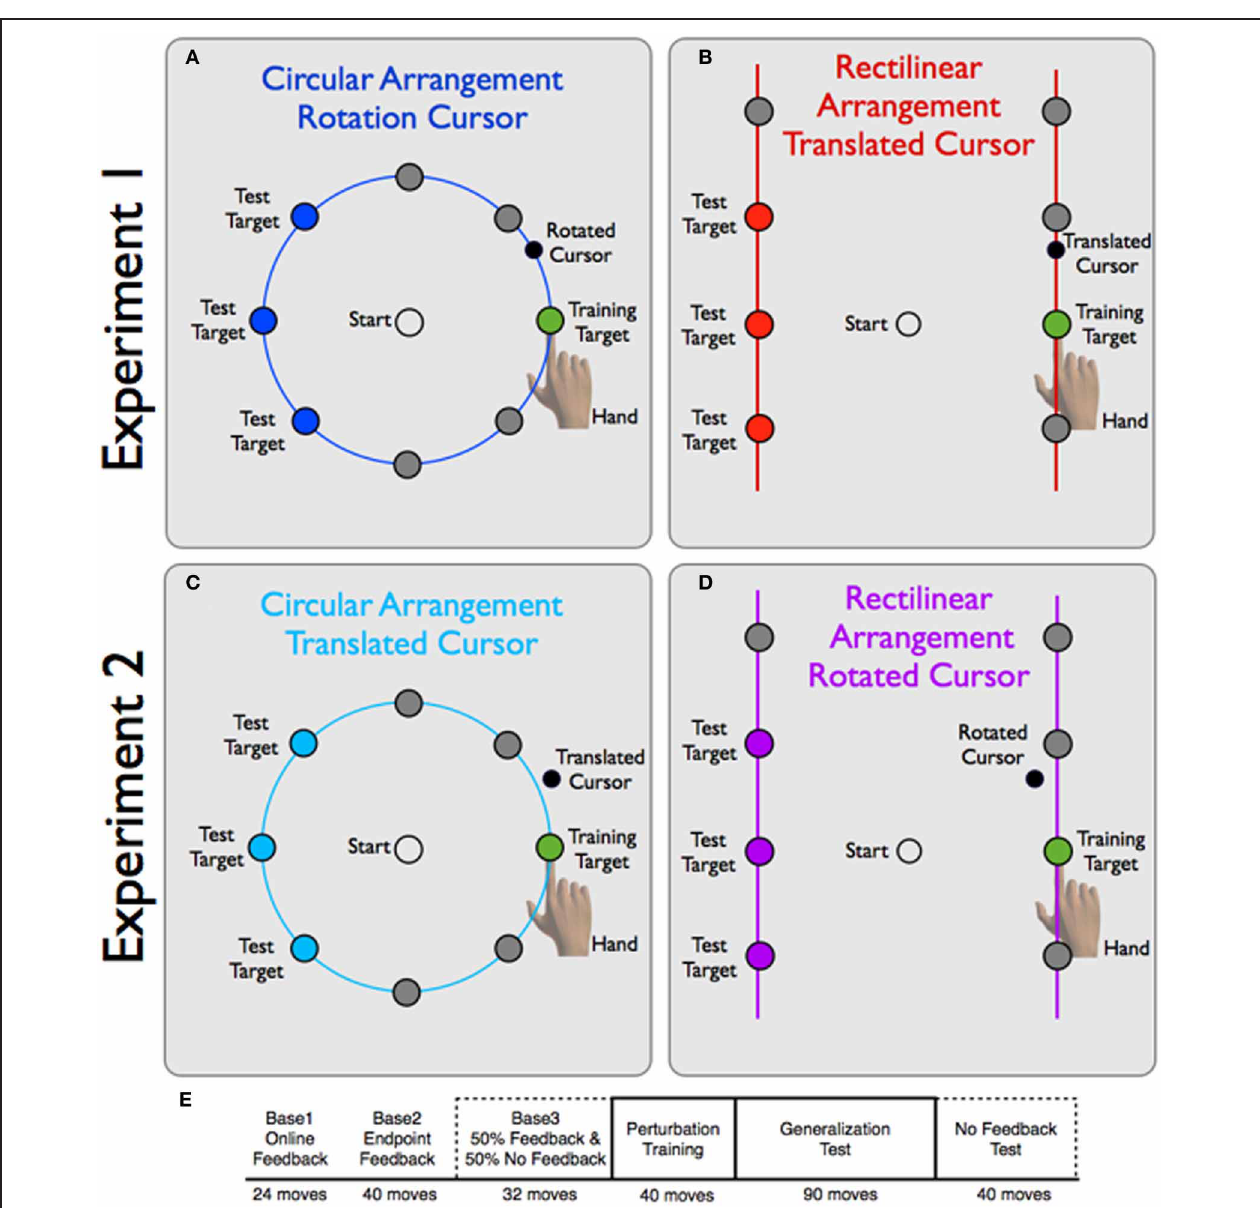
FIGURE 2 | Experimental design for Experiments 1 and 2. (A,B) Experiment 1: Participants in the CircleRotation group (A) viewed a blue ring. A target could appear at one of eight locations. During the training block, reaches were limited to the training target location and the visual perturbation was a 30 ◦ CCW rotation. The LineTranslation group (B) viewed two vertically oriented red lines, with four target locations on each vertical line. The visual perturbation here was a 4cm vertically-oriented visual shift. (C,D) Experiment 2: for the CircleTranslation group, targets were presented on a blue ring (C) and the visual perturbation for the training target was a vertical shift of